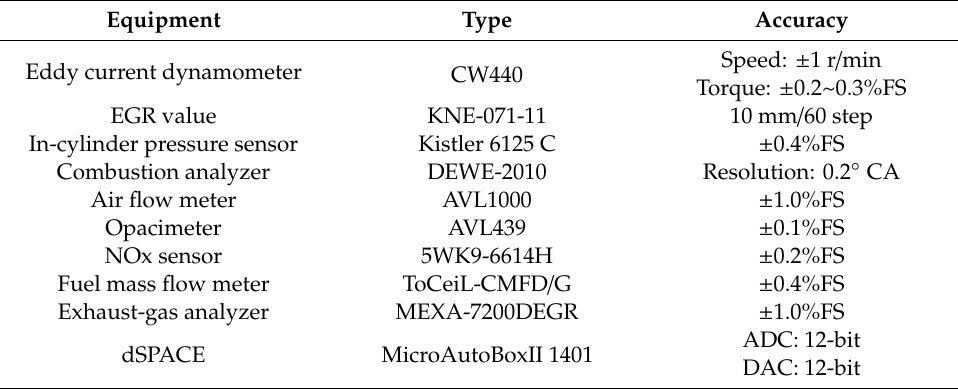
Table 2. The main instruments and accuracy.